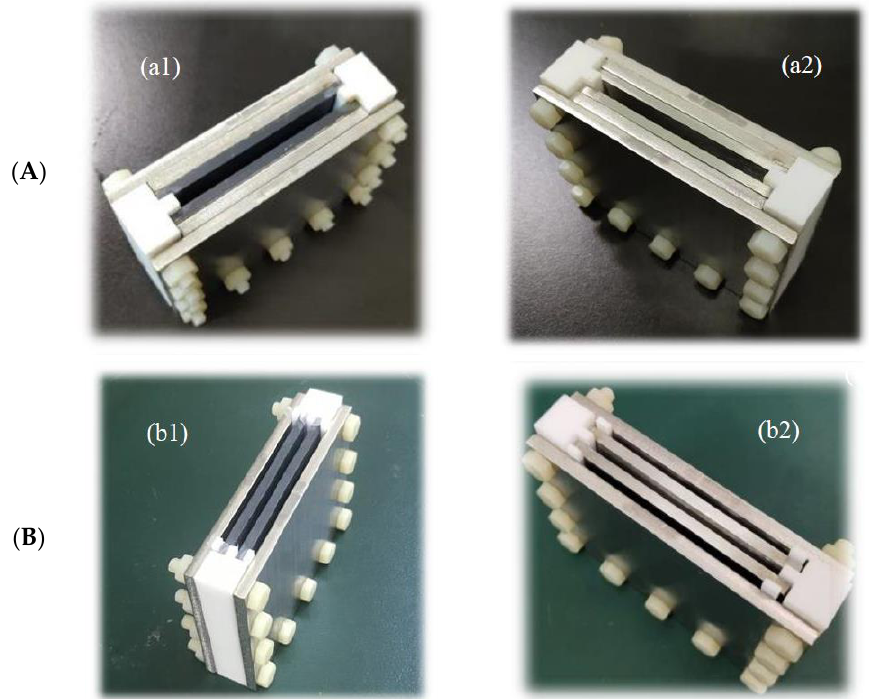
Figure 3. Assembled PEF chambers. ( A ) Chambers with BaTiO 3 plates and electrodes joined together by silver paste. ( a1 ): with BaTiO 3 plates; ( a2 ): BaTiO 3 plates replaced by stainless steel plates; ( B ) Chambers with extended gaps between BaTiO 3 plates and electrodes. ( b1 ): with BaTiO 3 plates; ( b2 ): BaTiO 3 plates replaced by stainless steel.